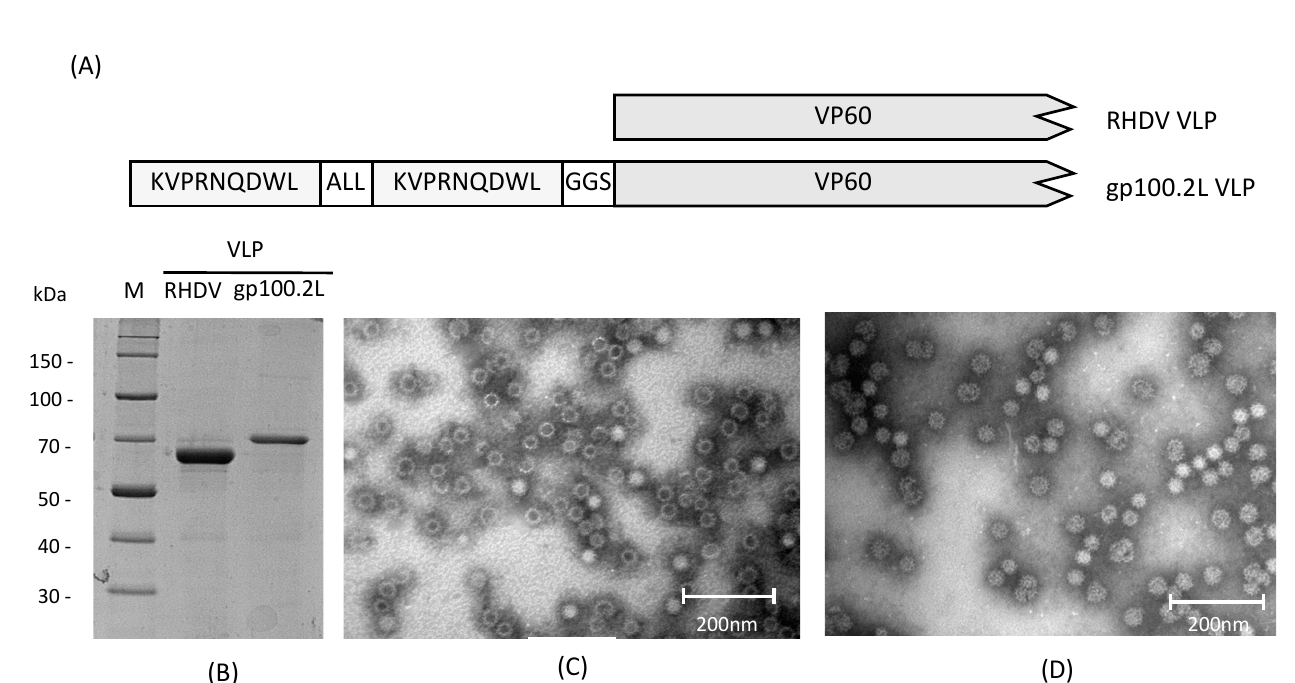
Figure 1. Expression and purification of virus-like particle (VLP). ( A ) Gene constructs used for expression of unmodified rabbit hemorrhagic disease virus (RHDV) VLP and RHDV VLP containing two gp100 epitopes (gp100.2L VLP). The 60 kDa capsid protein of RHDV is represented as VP60. Two copies of the gp100 epitope KVPRNQDWL are shown in the gp100.2L construct, along with a processing linker (ALL) and a flexible linker (GGS) at the junction between the gp100 epitopes and the VP60 sequence. ( B ) Ten percent SDS-PAGE of purified RHDV VLP and gp100.2L VLP stained with Coomassie Brilliant Blue G-250. ( C , D ) Transmission electron microscopy confirming particle assembly for RHDV and gp100.2L VLP, respectively. Upon overexpression, 180 copies of the VP60 monomer self-assemble into icosahedral capsids of approximately 40 nm in size.